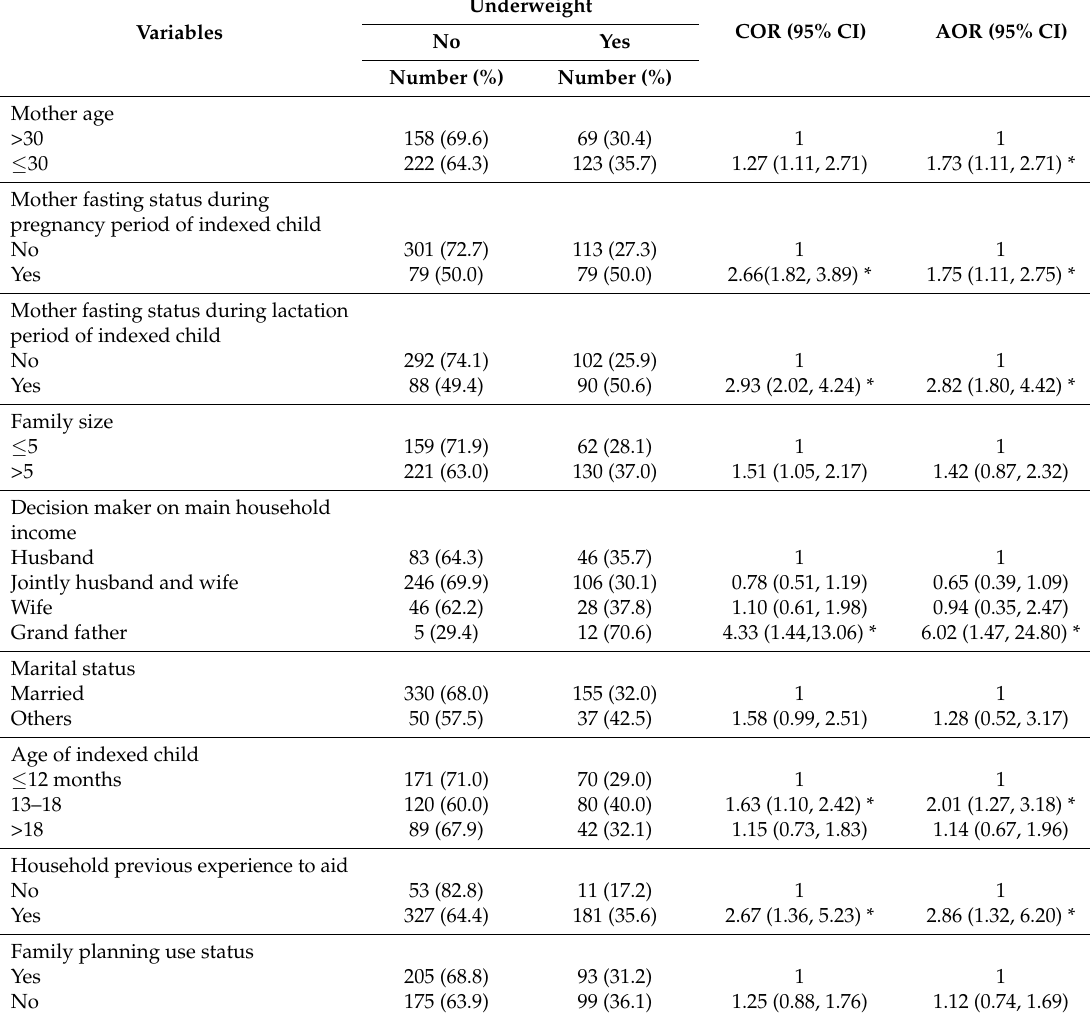
Table 3. Association of some socio-demographic, health, and feeding practice variables with maternal underweight (BMI) during Ethiopian Orthodox Lent fasting period in Rural Tigray, Northern Ethiopia ( n = 572). Underweight COR (95% CI) AOR (95% CI) No Yes Variables Number (%) Number